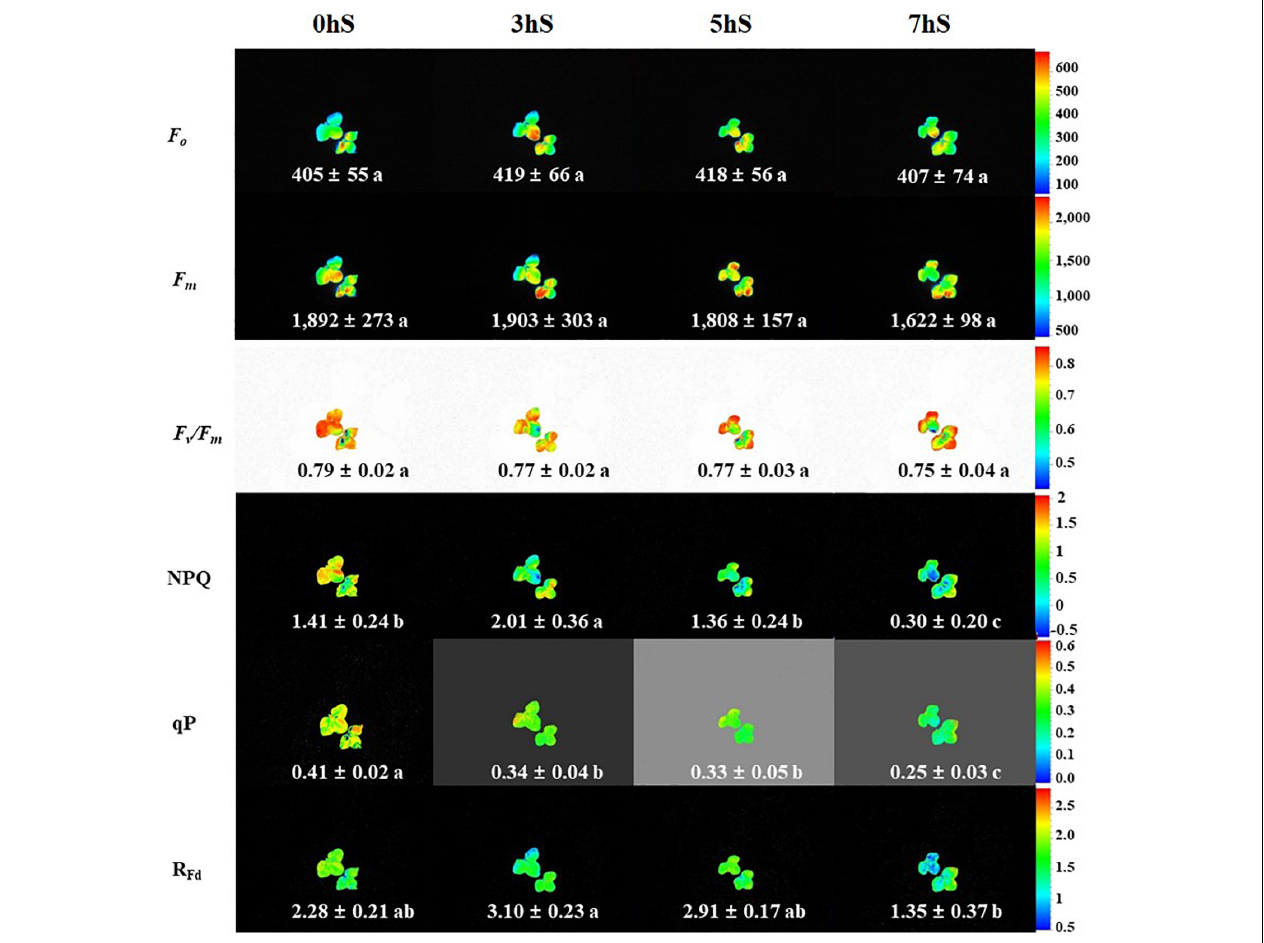
FIGURE 4 | Chlorophyll a fluorescence of strawberry ( Fragaria × ananassa ) leaves grown under various light intensity conditions in a smart greenhouse. 0 hS: non-shading treatment (control); 3 hS, three hours of shading until 10:00; 5 hS, five hours of shading until 12:00; 7 hS, seven hours of shading until 14:00; F o , minimum fluorescence when all photosystem II (PSII) reaction centers (RCs) are open; F m , maximal fluorescence when all PSII RCs are closed; F v / F m , maximum quantum yield of PSII photochemistry; NPQ, non-photochemical quenching of maximal fluorescence; qP, photochemical quenching of variable fluorescence; R Fd , fluorescence decline ratio in light. Average values included standard deviation followed by different lower-case letters within a column are significantly different (Duncan’s multiple range test, p < 0.05, n =